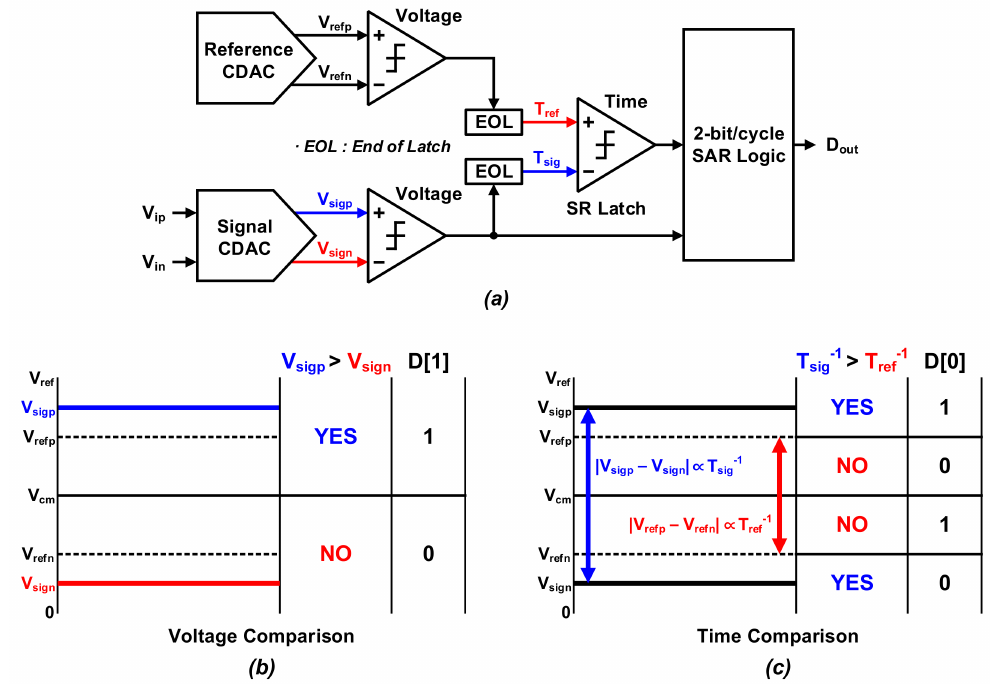
Figure 3. ( a ) Architecture of 2-bit/cycle SAR ADC for coarse conversion: ( b ) voltage comparison for upper bit; ( c ) time comparison for lower